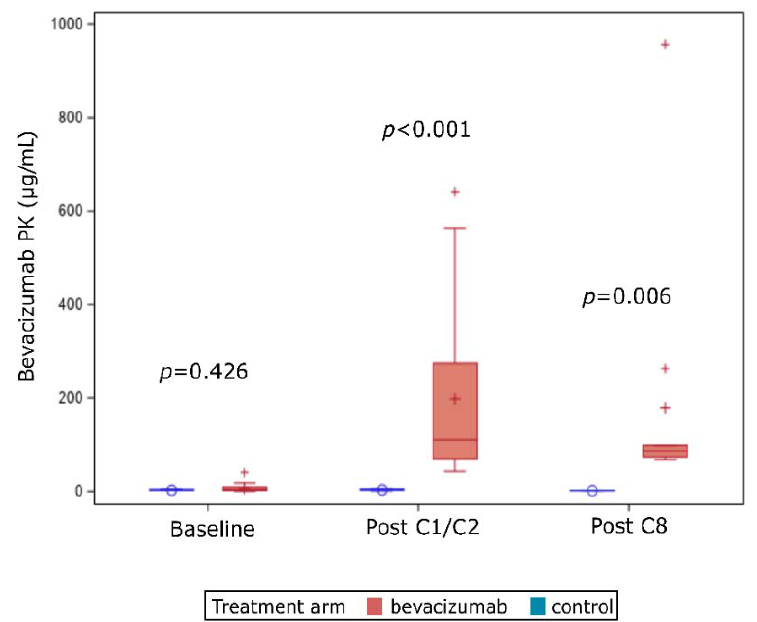
Figure 3. Box plots representing bevacizumab PK values at baseline, post C1-C2, and after treatment completion in both treatment arms.